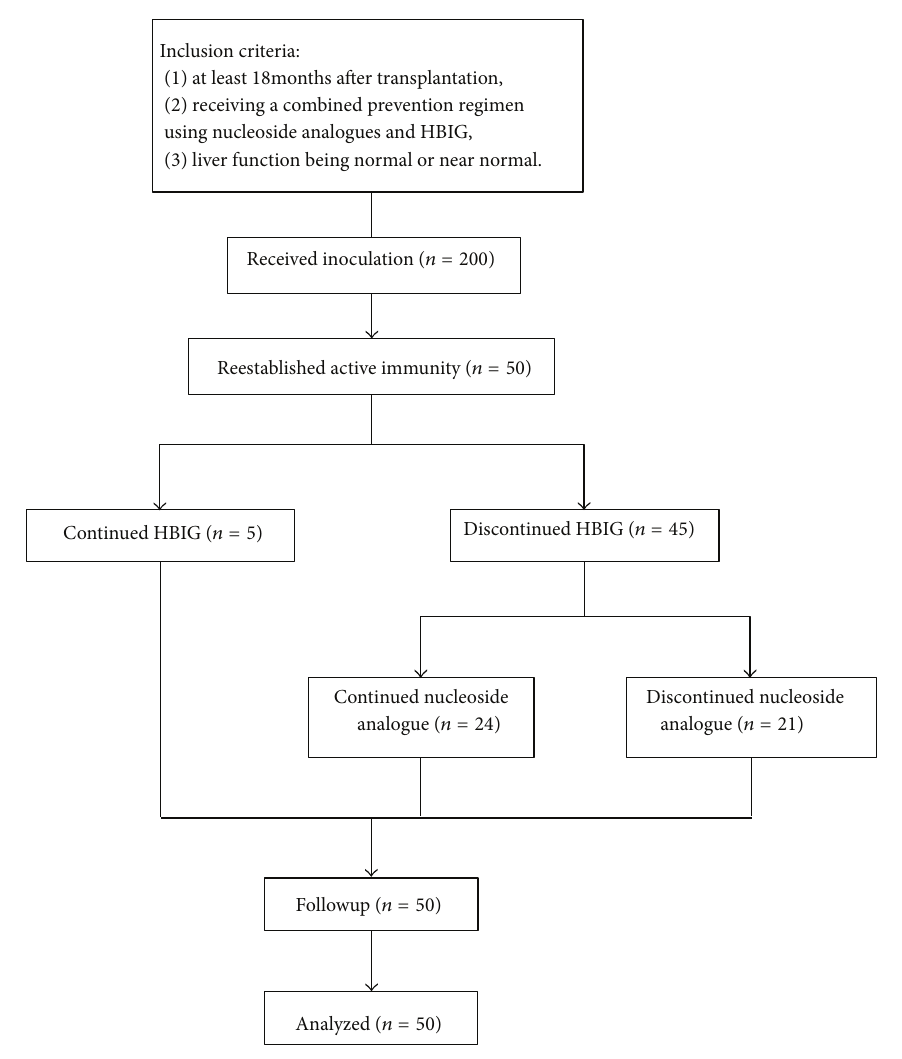
Figure 1: The study